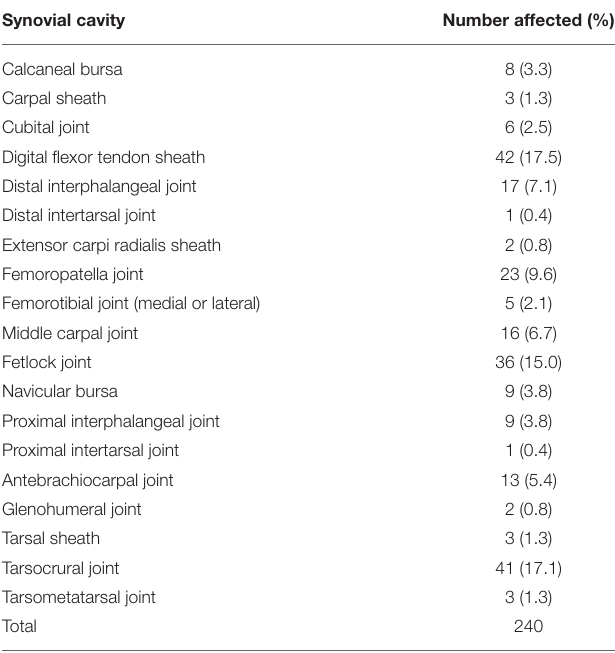
TABLE 1 | Frequency of distribution of infected synovial cavities. Synovial